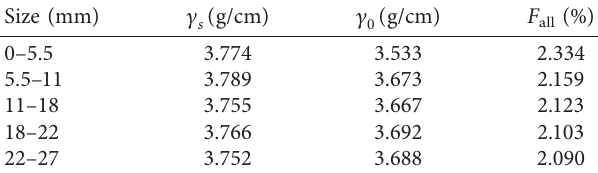
Table 4: Allowable free lime content for steel